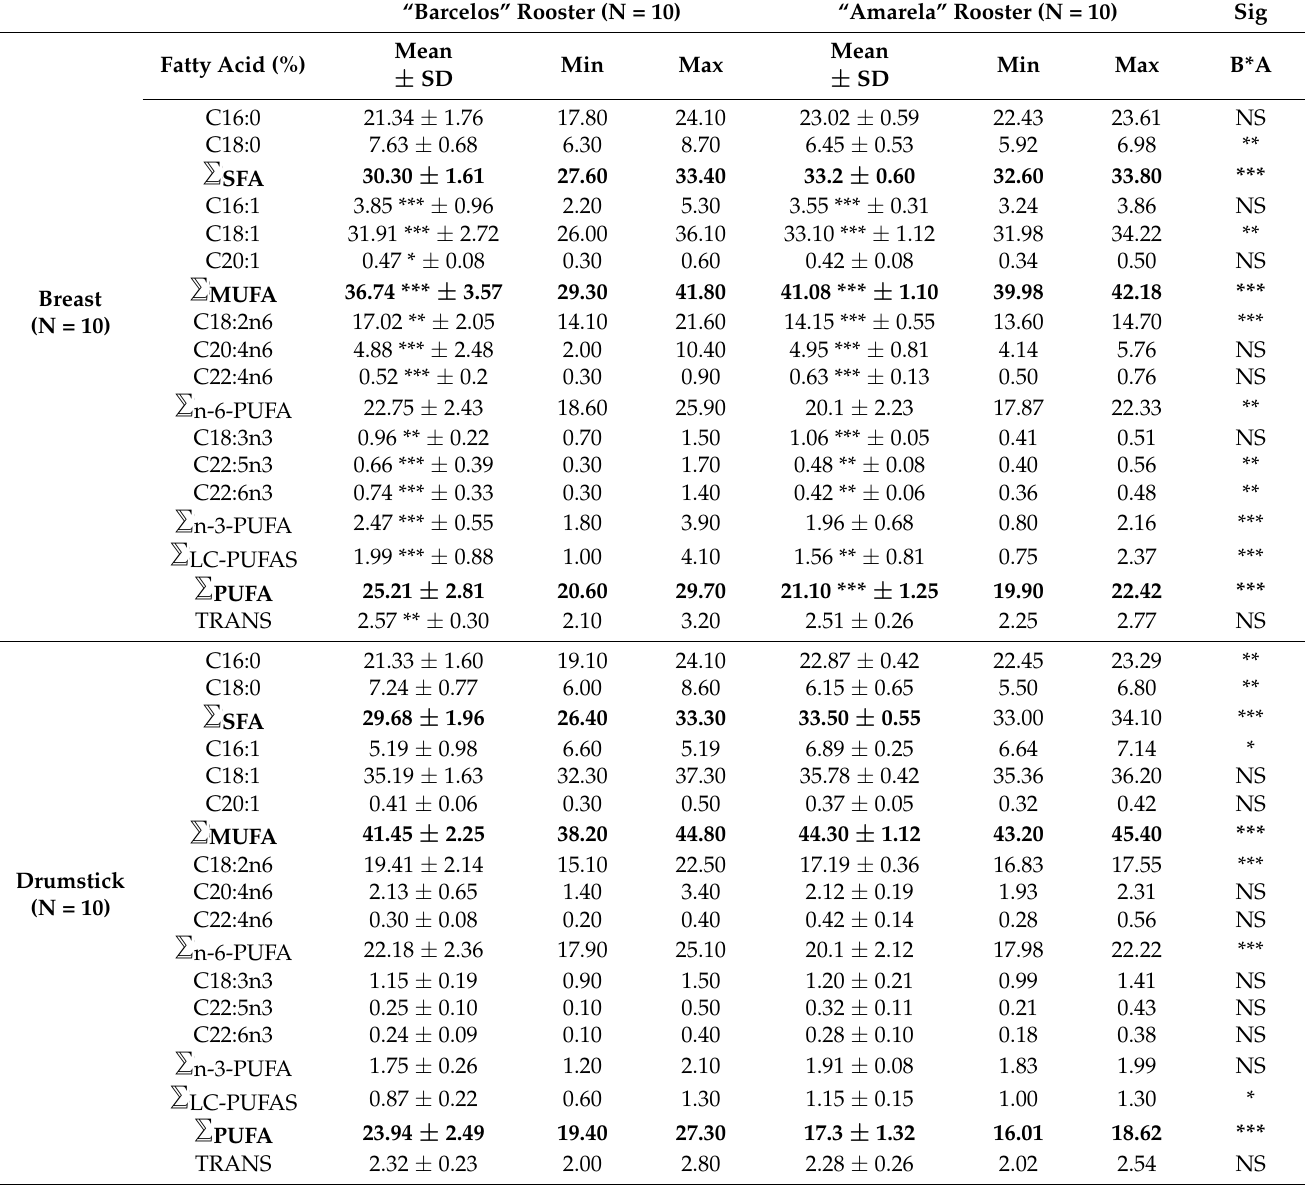
SD—standard deviation; Min—minimum; Max—maximum. SFA—saturated fatty acids; MUFA— monounsaturated fatty acids; and PUFA—polyunsaturated fatty acids. Averages with different symbols in the same column indicate significant differences for the same parameters between the